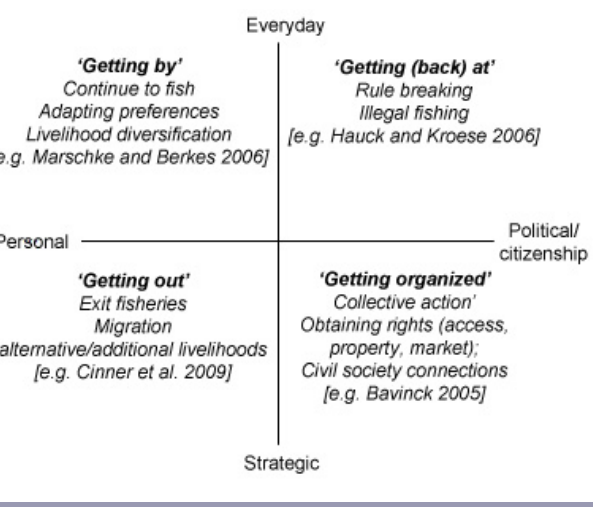
Fig. 1. Forms of agency exercised by people in poverty, applied to a fisheries context. Adapted from Lister (2004:130). Published with permission from Polity